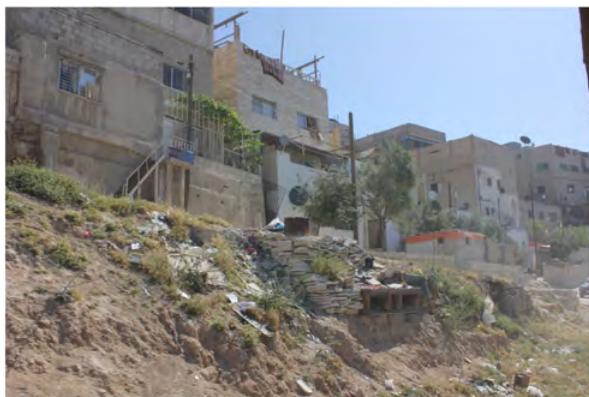
Figure 8. Examples of Fadlih ’s, Nutfih ’s and Arasah ’s 4. Source: Author